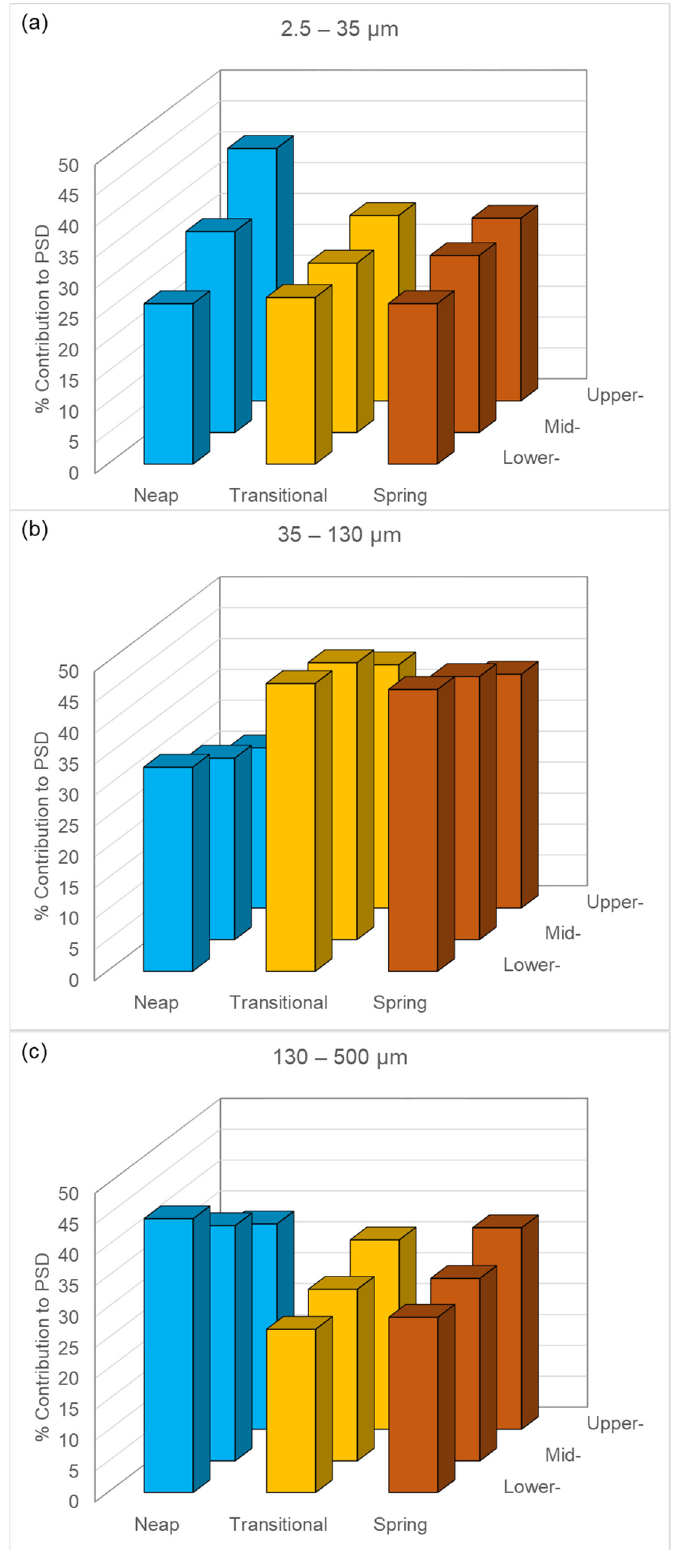
Figure 4. Depth-averaged combined size classes ( a ) 2.5–35 µ m, ( b ) 35–130 µ m and ( c ) 130–500 µ m contributions to the overall PSD at the lower-estuary (Site 1), mid-estuary (Sites 3, 4, and 9), and upper-estuary (Sites 5 and 7) LISST profile sites during neap (blue bars), transitional (orange bars), and spring (brown bars) tide conditions.